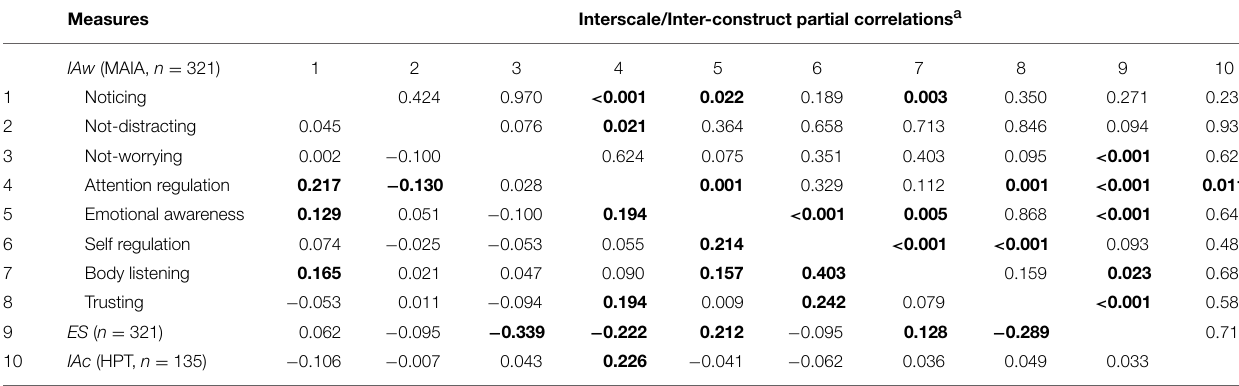
TABLE 3 | Partial correlations between IAw scales, ES, and IAc. Measures Interscale/Inter-construct partial correlations